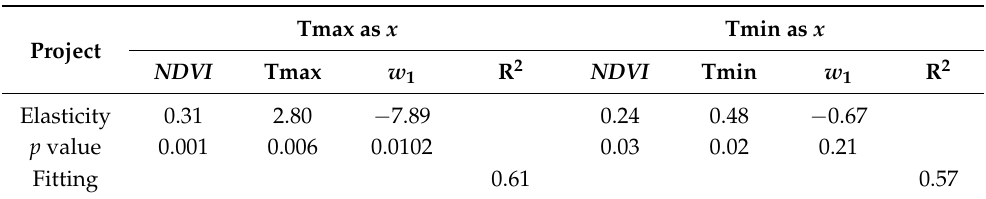
Table 3. Elasticity and significance of logarithmic function of climate change and ecological restoration on watershed factor ( n ).